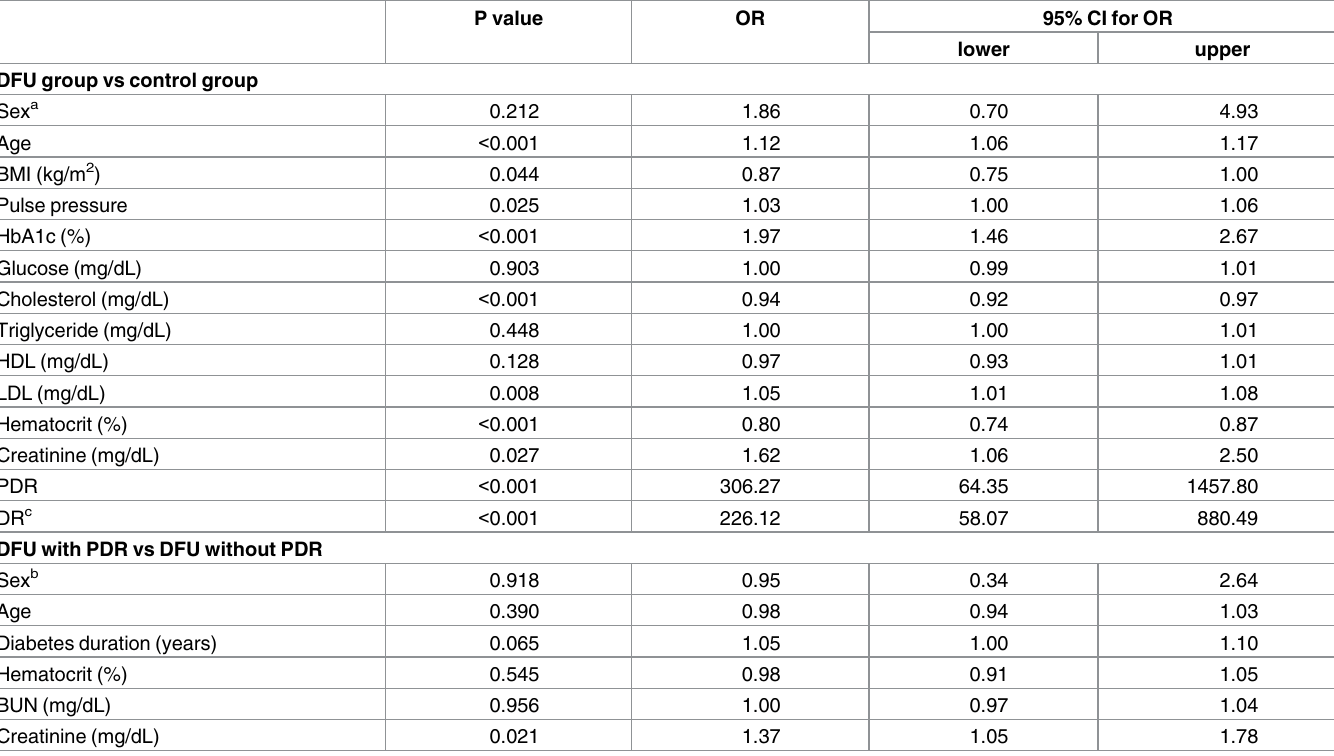
Table 2. Multivariable logistic regression analysis for comparisons 1) between the DFU group (n = 100) and control group (diabetes without DFU; n = 2496), and 2) between the DFU with PDR group (n = 55) and DFU without PDR group (n =